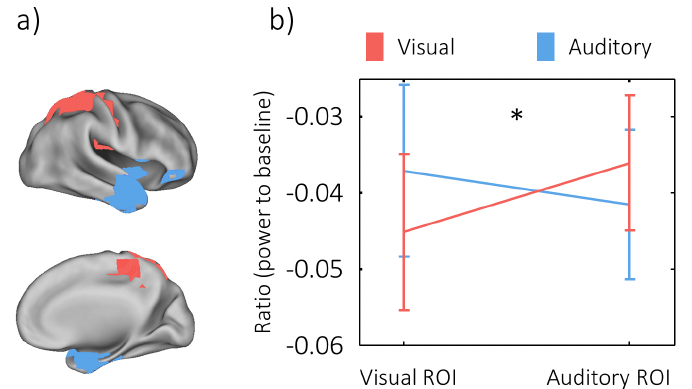
Fig 6. The interaction of power decreases with memory replay. Regions of visual and auditory similarity (a) showed a significant interaction with conditions ( F 1,23 = 6.58, p = 0.017), such that power decreases in the auditory region of similarity were stronger in the auditory condition, and power decreases in the visual region of similarity were stronger during visual retrieval